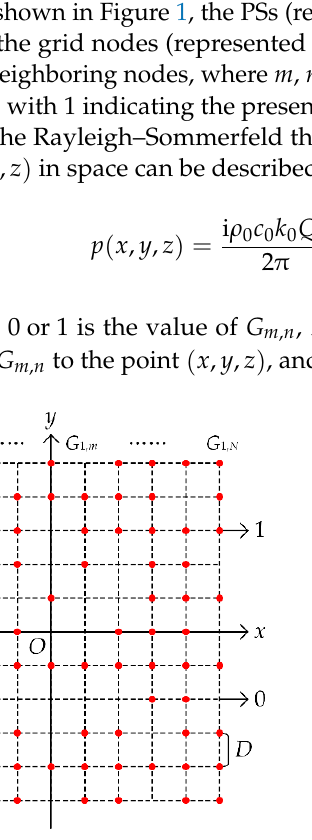
Figure 1. Schematic diagram of a hologram based on an array of identical PSs. The PSs (represented by red dots) are at the grid nodes (represented by G m , n ) of an N × N array with a distance d between two neighboring nodes, where m , n = 1, 2, 3, . . . , N . The grid node G m , n takes the value A m , n = 0 or 1, where 1 means a PS exists in this grid node and 0 means no PS. According to the Rayleigh–Sommerfeld theory, the diffraction pattern in the image plane is the superposition of the sound waves generated by these